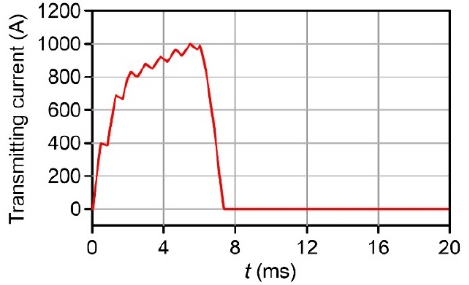
Figure 2. Transmitting waveform for VTEM system.